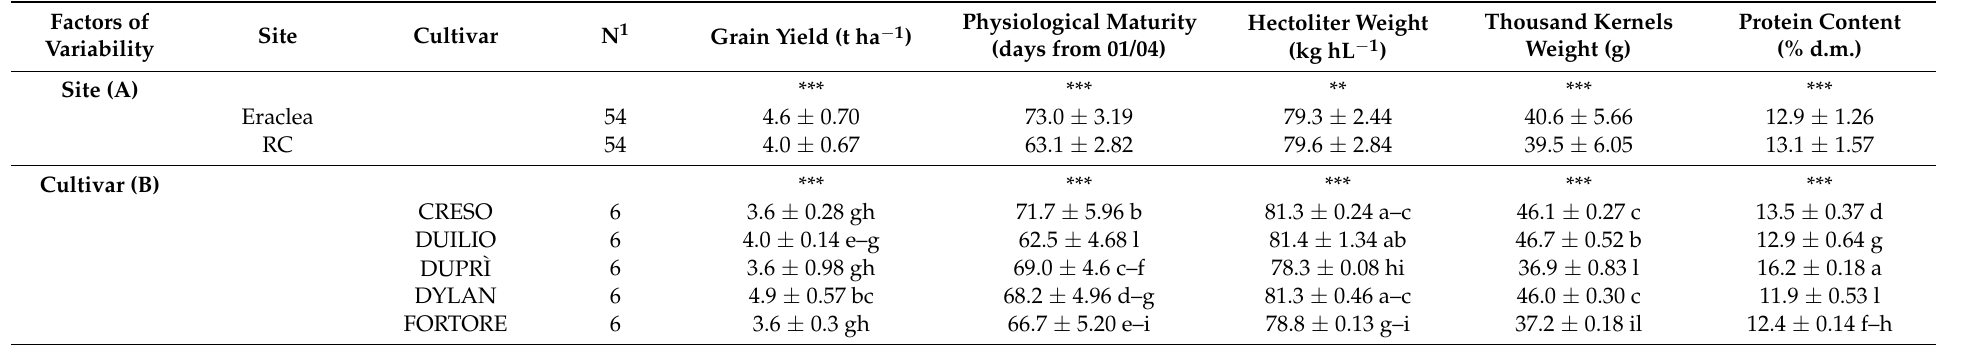
Table 4. Factorial ANOVA of the agronomic and qualitative traits of 16 Italian durum wheat cultivars and two reference cultivars of bread wheat evaluated for their susceptibility to Fusarium head blight (FHB). The test was performed in two different sites in northern and southern Italy, respectively: Eraclea (Veneto region) and Reggio Calabria (Calabria